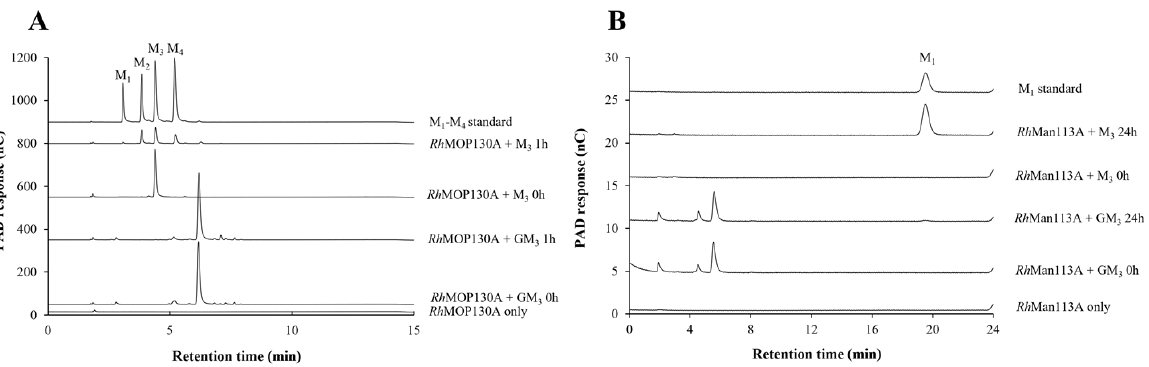
Figure 4. Incubation of mannotriose and galactosyl mannotriose with ( A ) Rh MOP130A or ( B ) Rh Man113A analyzed by anion-exchange chromatography with pulsed amperometric detection (HPAEC–PAD). ( A ) Column PA200 chromatograms of phosphorolysis incubations of Rh MOP130A (0.14 mg/mL) with 10 mM of either mannotriose (M3) or galactosylmannotriose (GM3). Standards of mannose (M1) to mannotetraose (M4) were applied for product quantification. Incubations were carried out at 37 °C for 0 – 1 h in 100 mM sodium citrate buffer (pH 6.0). ( B ) Column PA20-chromatograms for analysis of M1 release in incubations of Rh Man113A (5 µg/mL) with 5 mM of M3 or GM3. M1 was used as the standard for quantification. Incubations were carried out at 30 °C for 0 – 24 h in 50 mM sodium phosphate buffer (pH 6.0). Data from triplicate incubations and mean values ± SD (standard deviation) are presented. Table 1. The specific activity of the β -mannan-oligosaccharide phosphorylase Rh MOP130A in syn- thesis and phosphorolysis reaction directions.